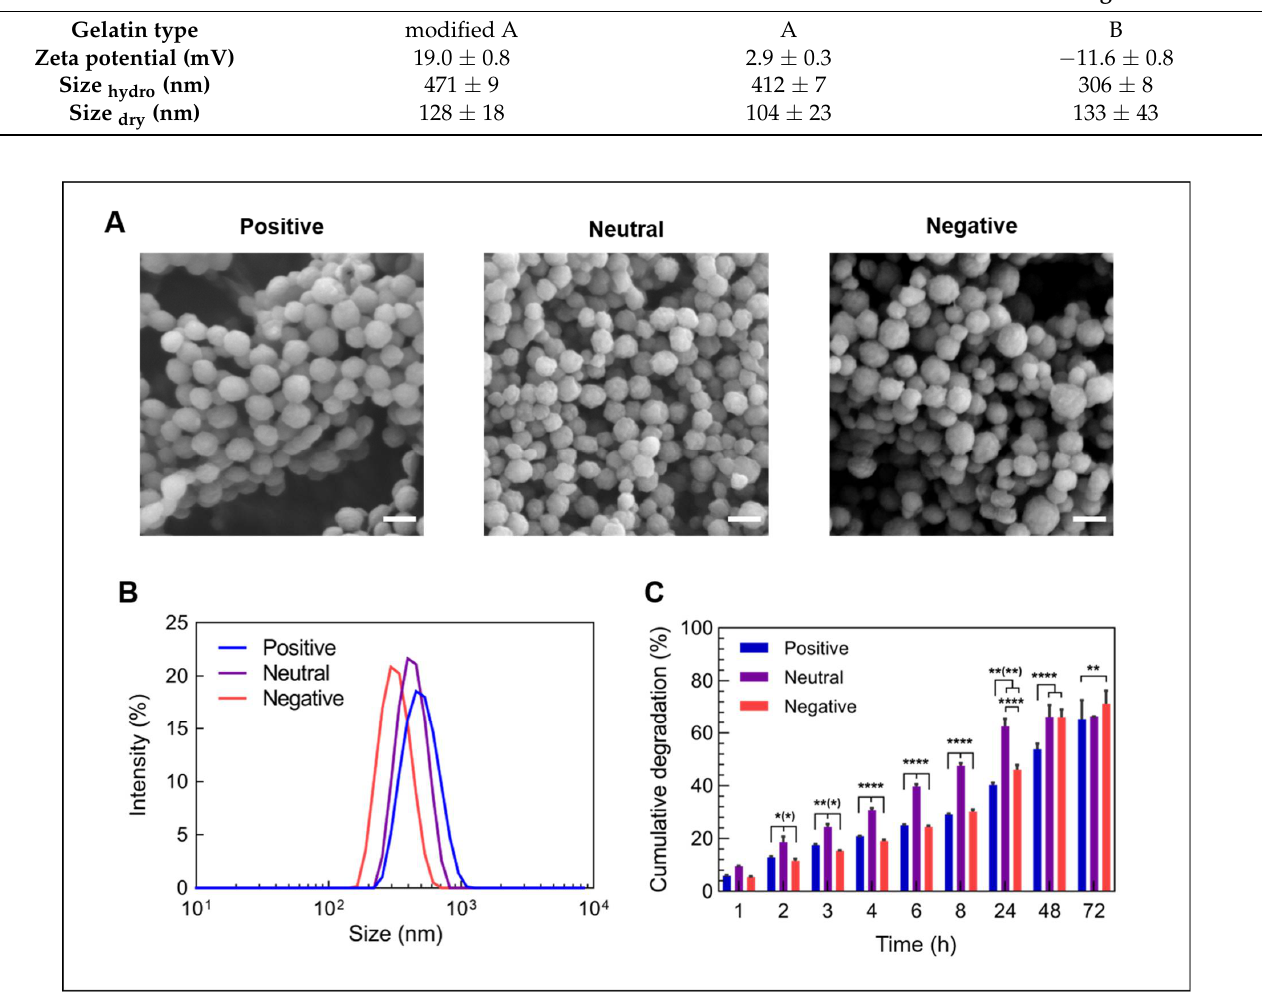
Figure 1. Characteristics of differently charged, bare gelatin nanoparticles. ( A ) SEM images of lyophilized gelatin nanoparticles with different surface charges, ( B ) size distribution of gelatin nanoparticles in an aqueous solution and ( C ) the degradation of gelatin nanoparticles in the presence of collagenase type 1A at pH 7.4 ( n = 3 for positive and negative particles, n = 2 for neutral particles). Scale bars represents 200 nm. Statistical significance is shown as * p < 0.05, ** p < 0.01, and **** p < 0.0001.